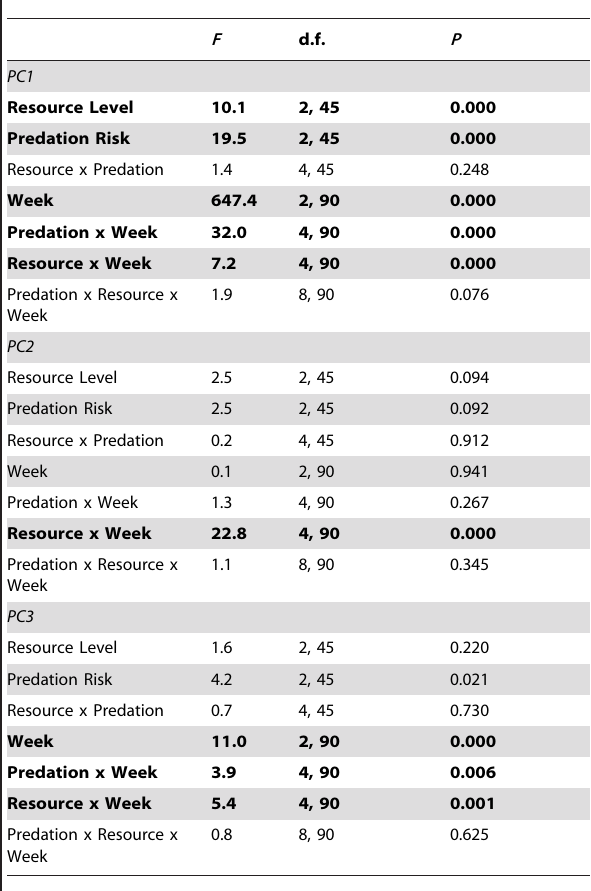
Table 1. Univariate results of a factorial ANOVA using the first three principal components from PCAs on Northern leopard frog ( Lithobates pipiens ) tadpole shape variables, over three weeks of experimentation at three resource level treatments (2%, 5%, and 20% of total tadpole mass per aquarium given as food every other day) and three predation risk level treatments (0 mL, 100 mL, and 300 mL predator-treated water added